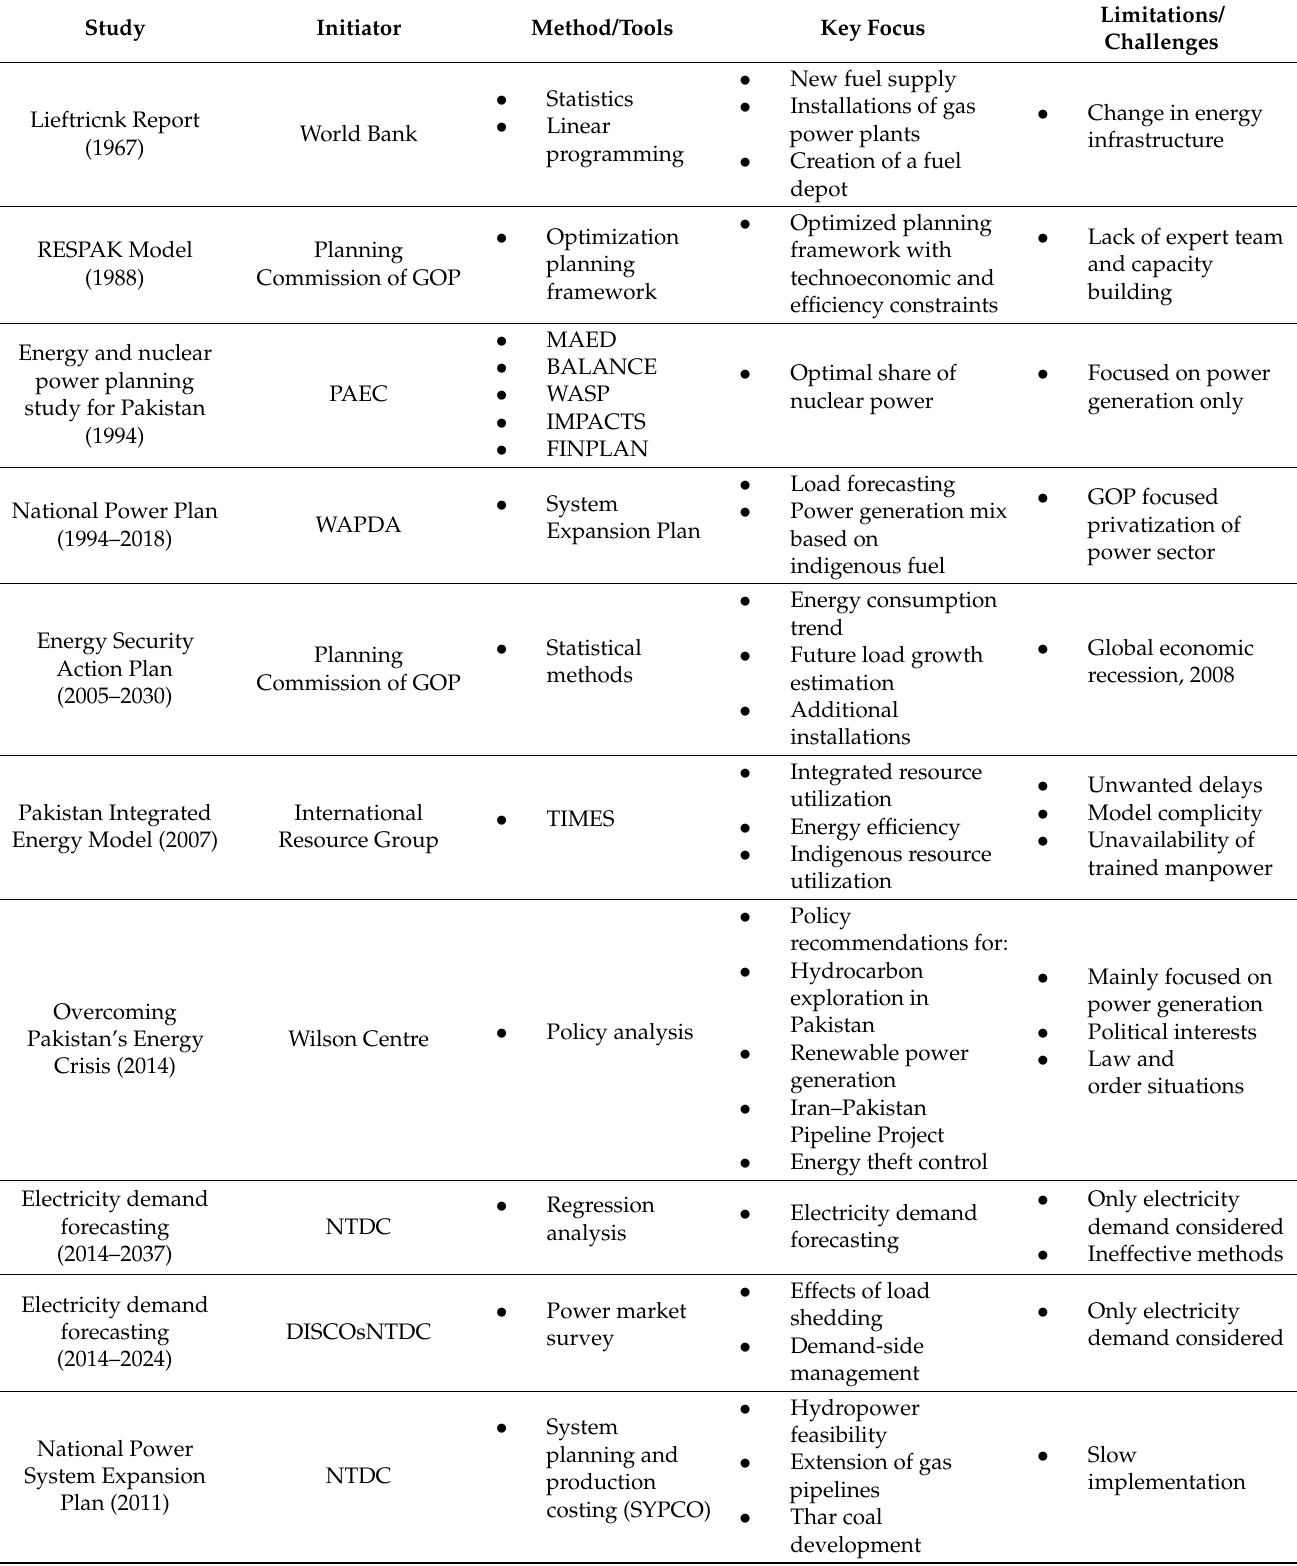
Table 2. Government-level studies analyzing the energy